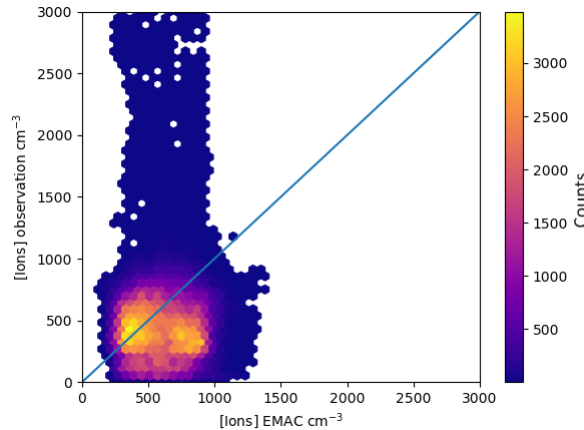
Figure 1. Comparison of observed ground-level ion concentration with simulated concentration at the six measurement sites with ion measurements (Table